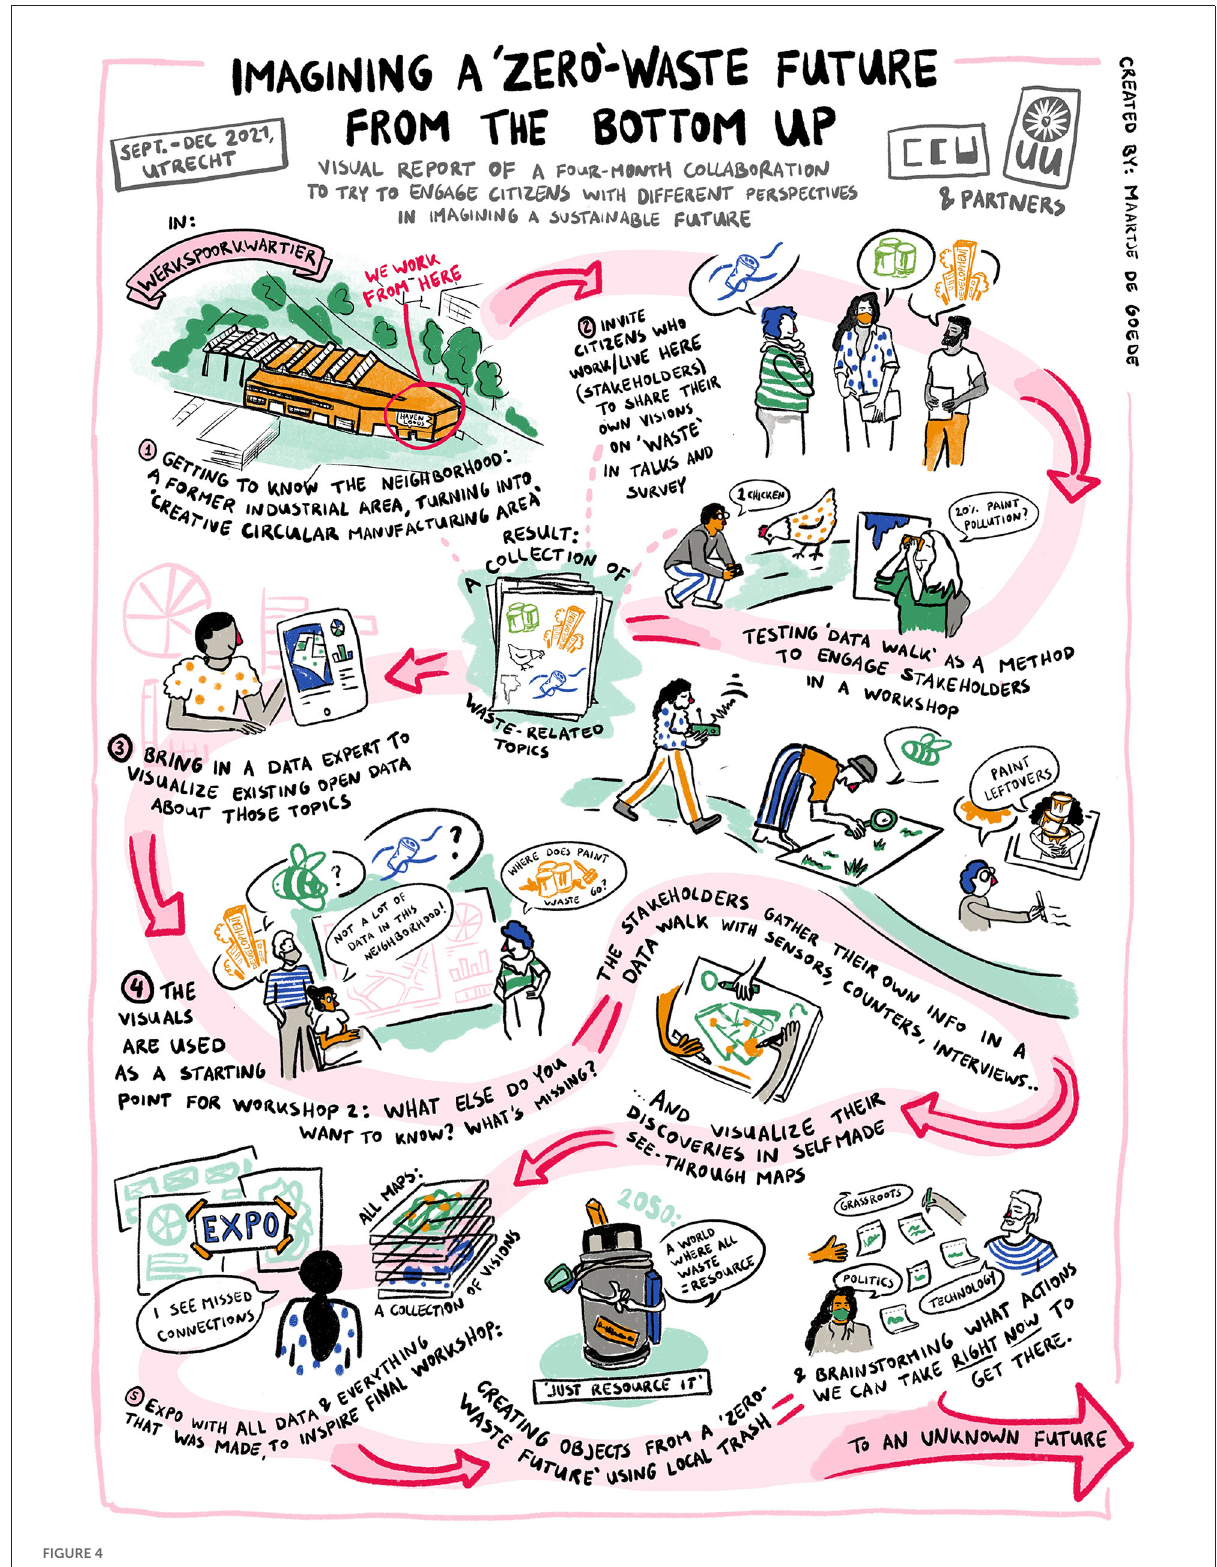
FIGURE4 Visual report by Maartje de Goede translating our methodological approach into the medium of illustration.